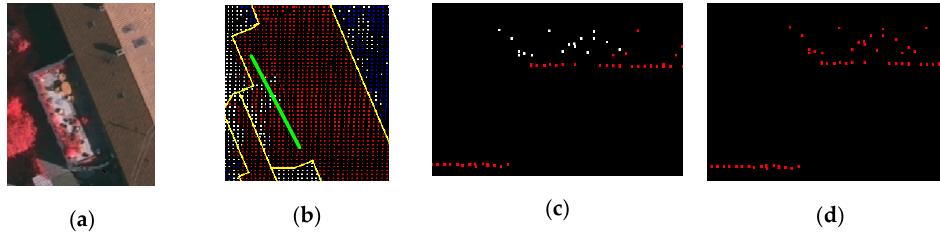
Figure 6. Roof terrace. ( a ) Orthophoto; ( b ) Point data. Yellow lines are reference vectors provided by ISPRS. The approximate location of profile is indicated by the green line; ( c ) Profile before consistency constraint; ( d ) Profile after consistency constraint.